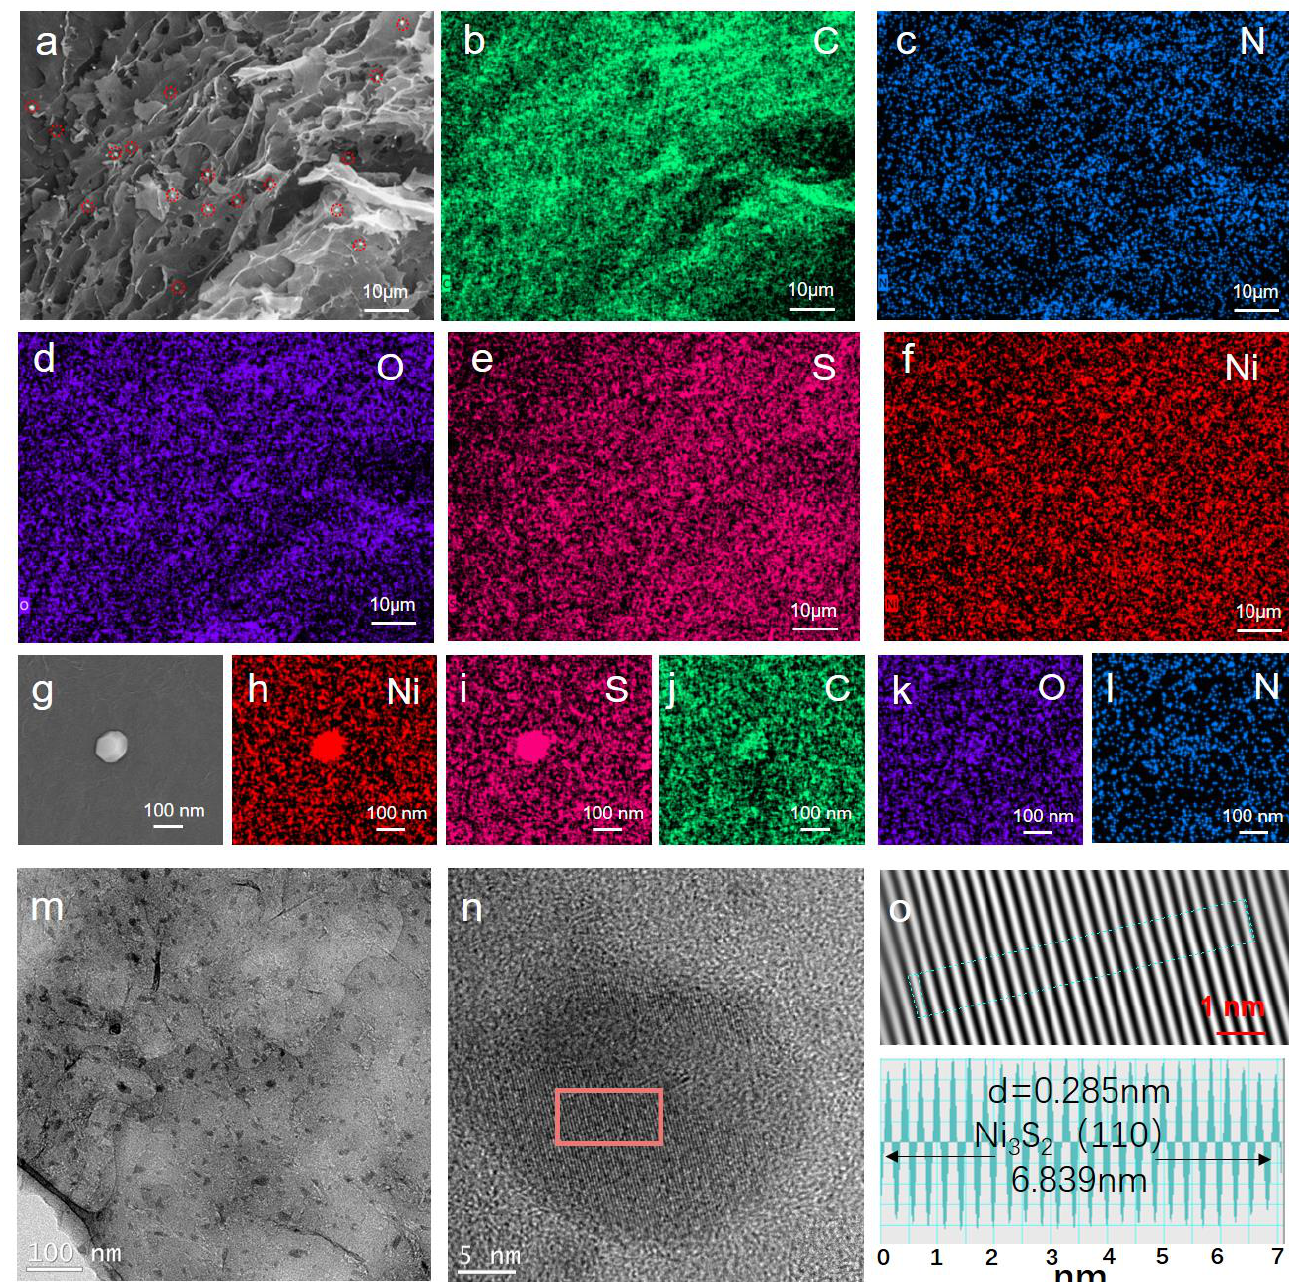
Figure 4. ( a , g ) SEM and ( b – f , h – l ) corresponding EDS mapping images, ( m ) TEM, ( n ) HRTEM, and Figure 4. ( a,g ) SEM and ( b – f, h – l) corresponding EDS mapping images, ( m ) TEM, ( n ) HRTEM, and ( o ) IFFT image and the measured interplanar spacing of as-prepared Ni 3 S 2 ( o ) IFFT image and the measured interplanar spacing of as-prepared Ni 3 S 2 @NSGA-650.